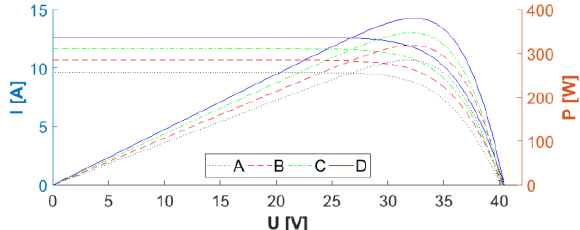
Fig. 2. Current-voltage characteristics and power characteristics of the LG300N1T-G4 bifacial panel for different BGE values.